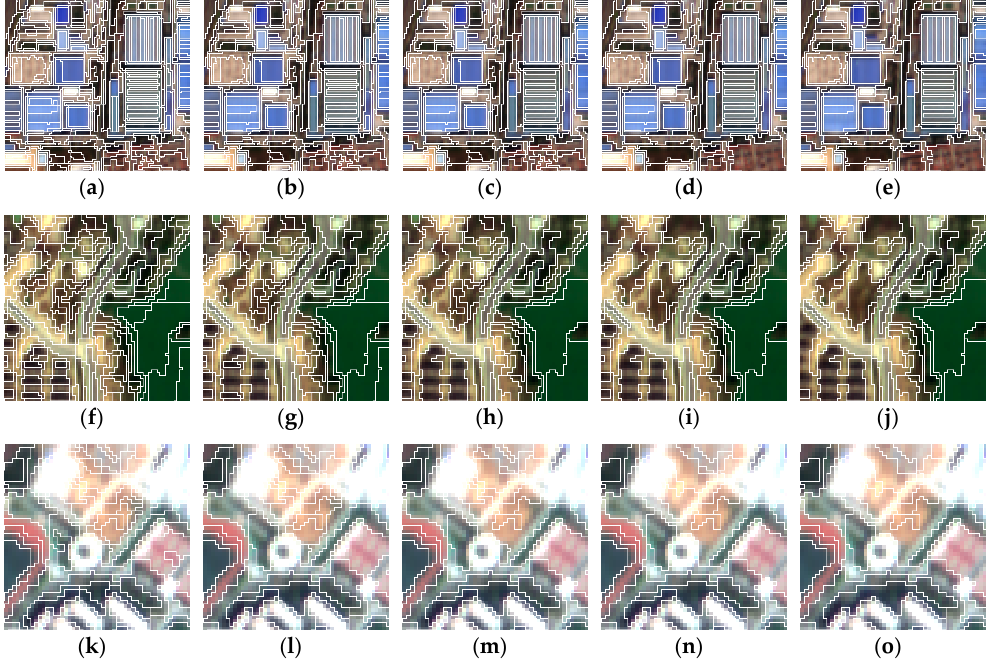
Figure 6. Illustration of several objects of images in data after multi-resolution segmentation by fractal net evolution approach (FNEA). Segmentation scales on the first location are set as ( a ) 30, ( b ) 35, ( c ) 40, ( d ) 45, ( e ) 50, respectively. Segmentation scales on the second location are set as ( f ) 25, ( g ) 30, ( h ) 35, ( i ) 40, ( j ) 45, respectively. Segmentation scales on the third location are set as ( k ) 25, ( l ) 30, ( m ) 35, ( n ) 40, ( o ) 45, respectively.